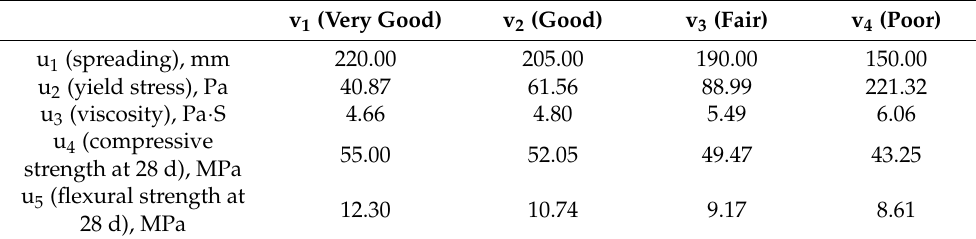
Table 7. Fuzzy evaluation standard values based on testing